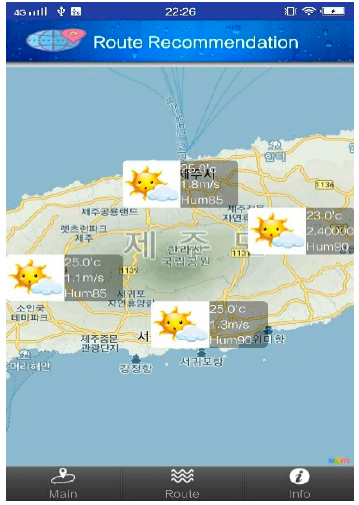
Figure 13. Mobile tourist application main interface.